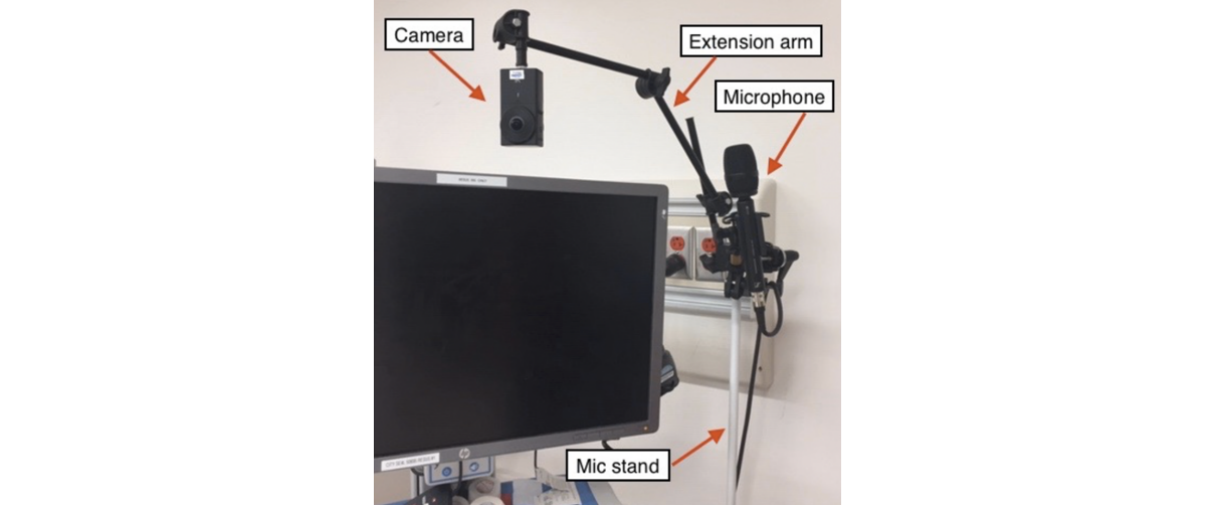
Figure 3. From the charting nurse perspective, the equipment configuration using a mic stand and extension